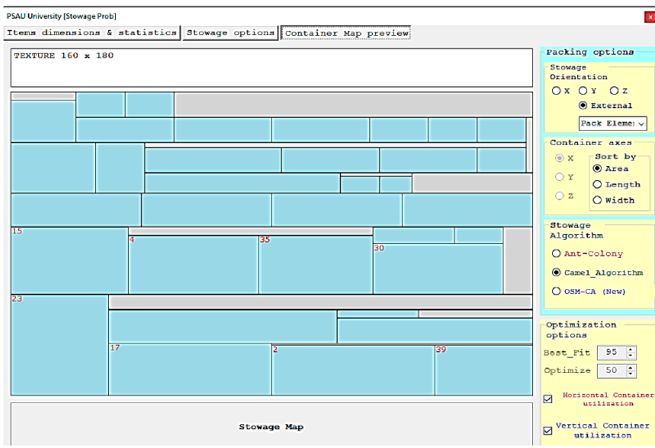
Figure A13. The stowage map by camel algorithm for third station on the distribution path.